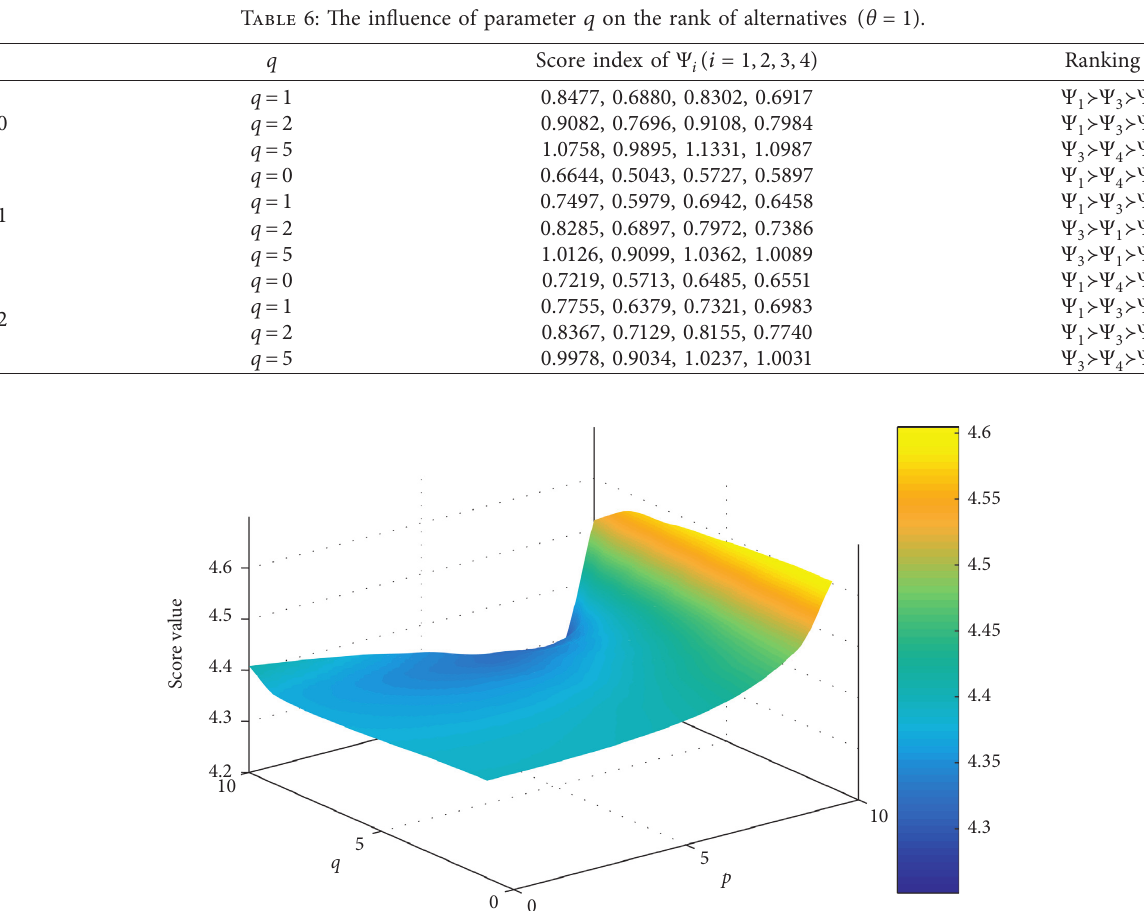
Figure 2: Scores of A